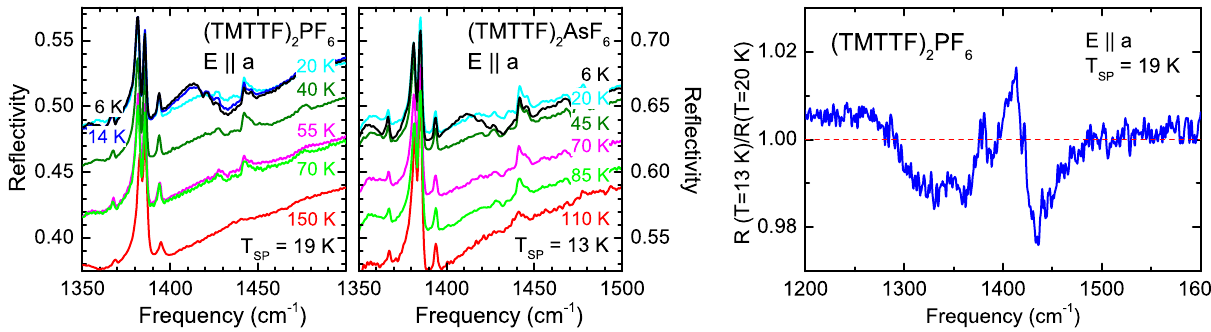
PF and (TMTTF) AsF measured for the polarization 2 6 2 6 . The SP PF , in the right panel. 2 6